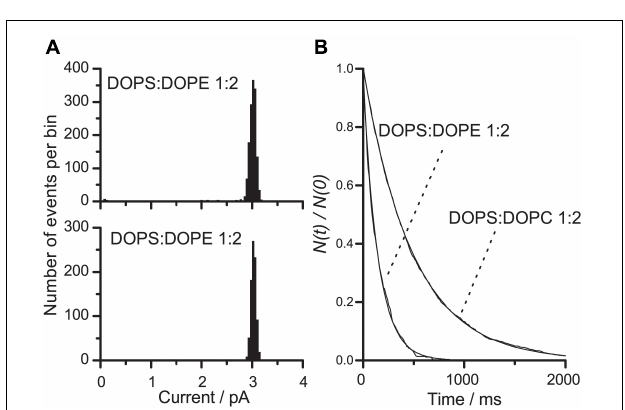
FIGURE 5 | VgA(15) channel function in DOPS:DOPE/ n -decane and DOPS:DOPC/ n -decane bilayers. (A) Current transition amplitude